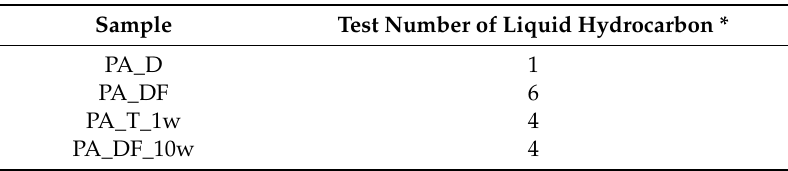
Table 4. Results of oil repellency